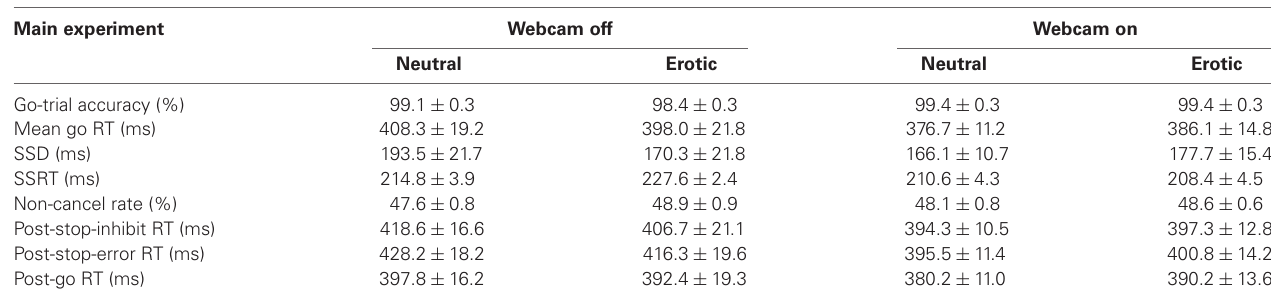
Table 1 | Summary of the main experiment results (mean ± standard